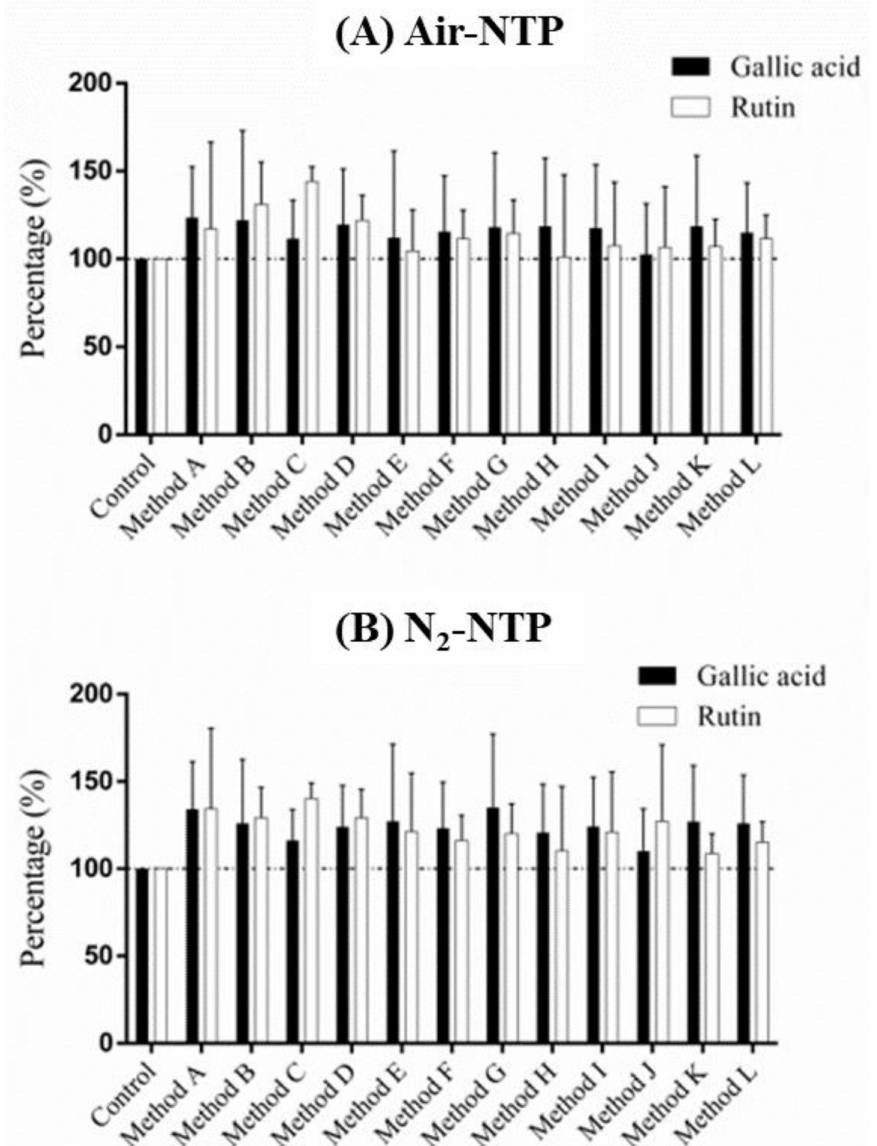
Figure 5. Levels of gallic acid and rutin in the seeds before and after NTP treatment: ( A ) air-NTP treatment and ( B ) N 2 -NTP